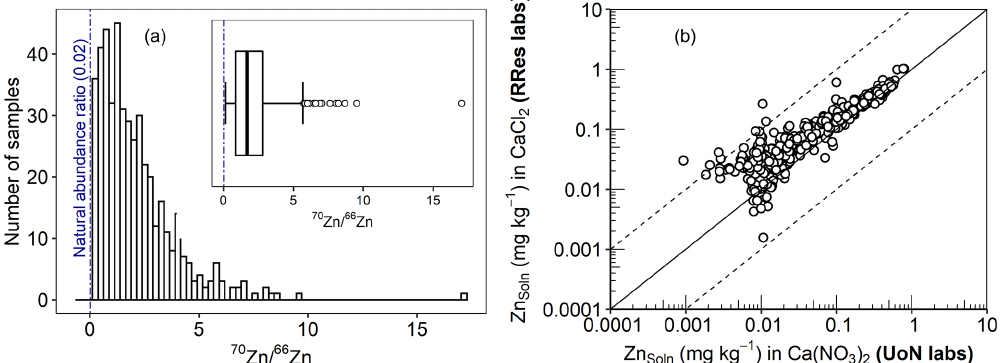
Figure 4. (a) Histogram of the isotopic ratio ( 70 Zn / 66 Zn) in the spiked soils. (b) An inter-laboratory comparison of Zn Soln extracted in 0.01MCa(NO 3 ) 2 at the University of Nottingham ( x axis) and in 0.01CaCl 2 at Rothamsted Research ( y axis). The dashed lines and the solid line in panel (b) represent 1 log unit interval and the line of equality, respectively.